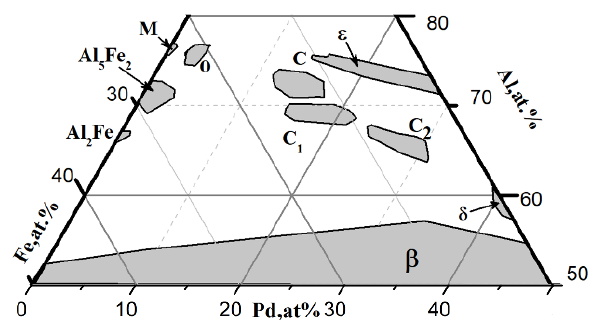
Figure 1. Overall compositions of the high-Al Al–Pd–Fe phases between 1020 ◦ C and 900 ◦ C; Region of the ε -phases is given for 750 ◦ C. (M: monoclinic M-Al 13 Fe 4 ; O: orthorhombic O-Al 13 (Fe,Pd) 4 ; δ : Al 3 Pd 2 ; β : Al(Pd,Fe); ε : Al 3 PdFex (the x component is between 0% and 10%); C-phase: in a compositional range of 1 – 2 at.% around Al 71.5 Pd 15.0 Fe 13.5 ; C 1 -phase: in a compositional range between Al 69.5 Pd 14.8 Fe 15.7 and Al 68.5 Pd 22.2 Fe 9.3 ; C 2 -phase: in a compositional range around Al 67.0 Pd 24.5 Fe 8.5 ).